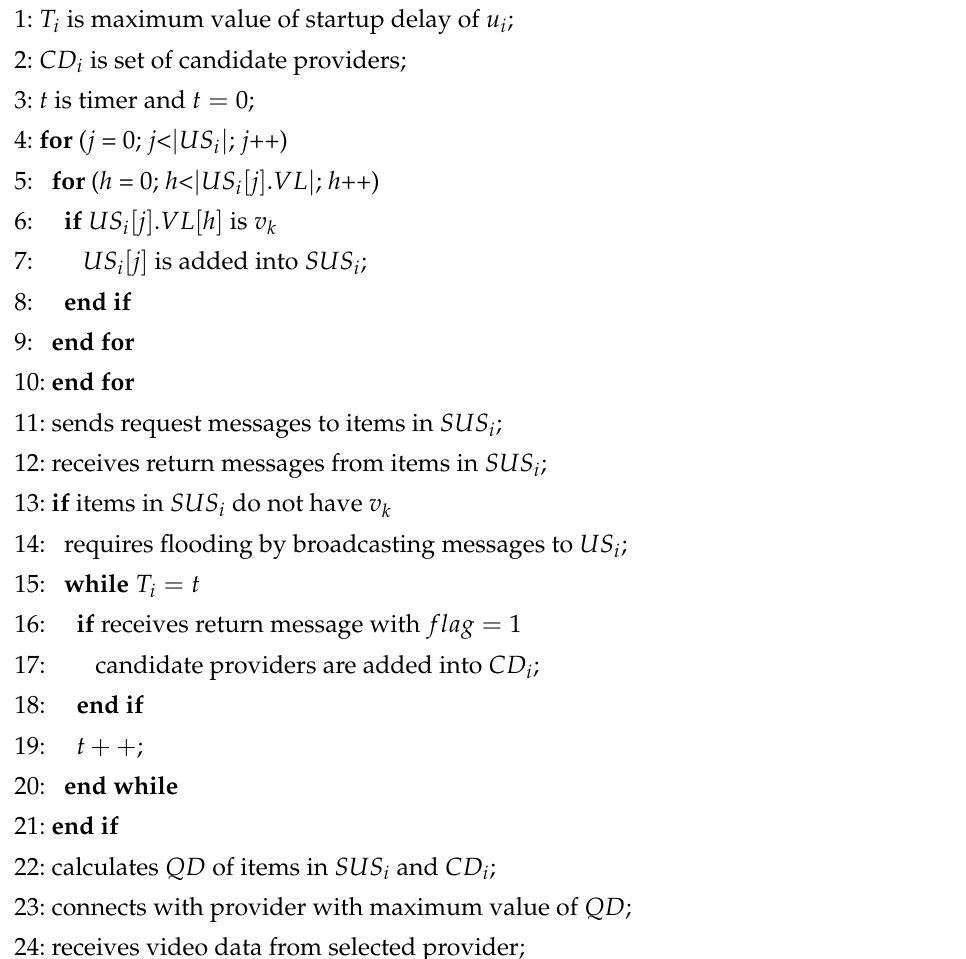
Algorithm 1 Video Provider